Question: What type of chart is this?
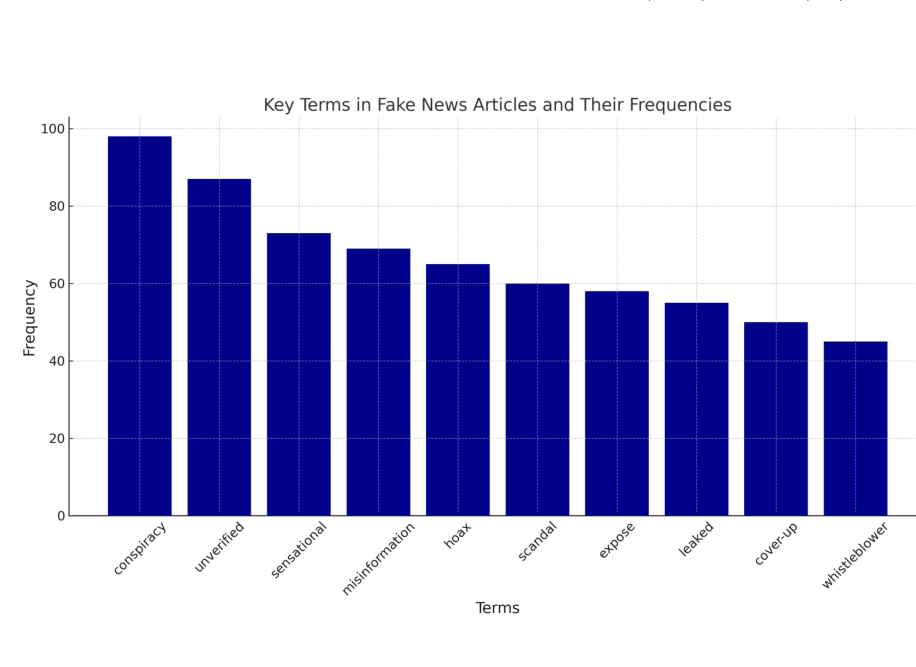
Answer: bar